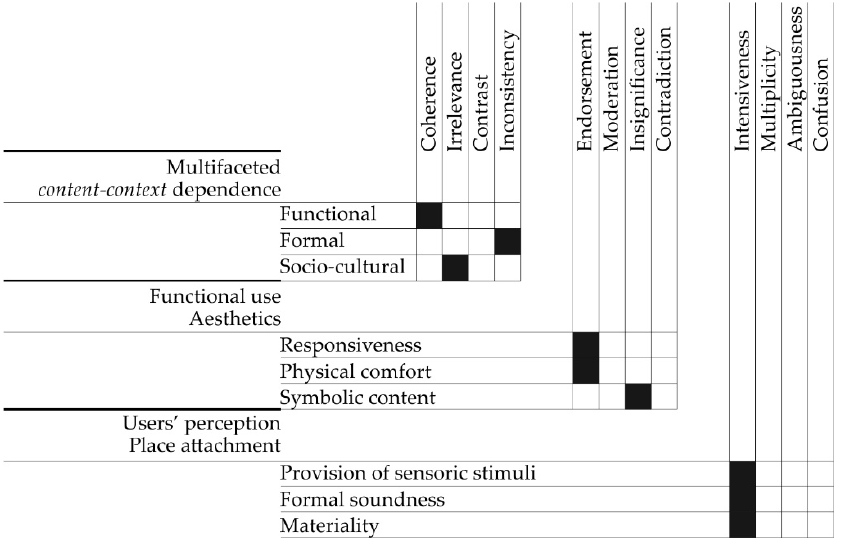
( c ) Figure 5. Polish National Radio Symphony Orchestra House, Katowice, 2014, arch. Konior Studio. ( a ) The inner precast concrete cladding of the main concert hall. Source: M. Charciarek [33]; ( b ): The inner cast concrete layered wall of the main lobby, (photo by M. Celadyn); ( c ): Main entrance. Source: https://commons.wikimedia.org/wiki/File:Kato- wice_05.15_NOSPR_2.JPG, photo by M. Mróz. The multilayered shell of the main concert hall volume, being a separate structure set in a multifunctional atrium, introduced innovative building technologies to respond to the functional requirements of the main music hall, providing the audience with a high quality experience [39]. The main concert hall’s acoustic parameters met all the highest